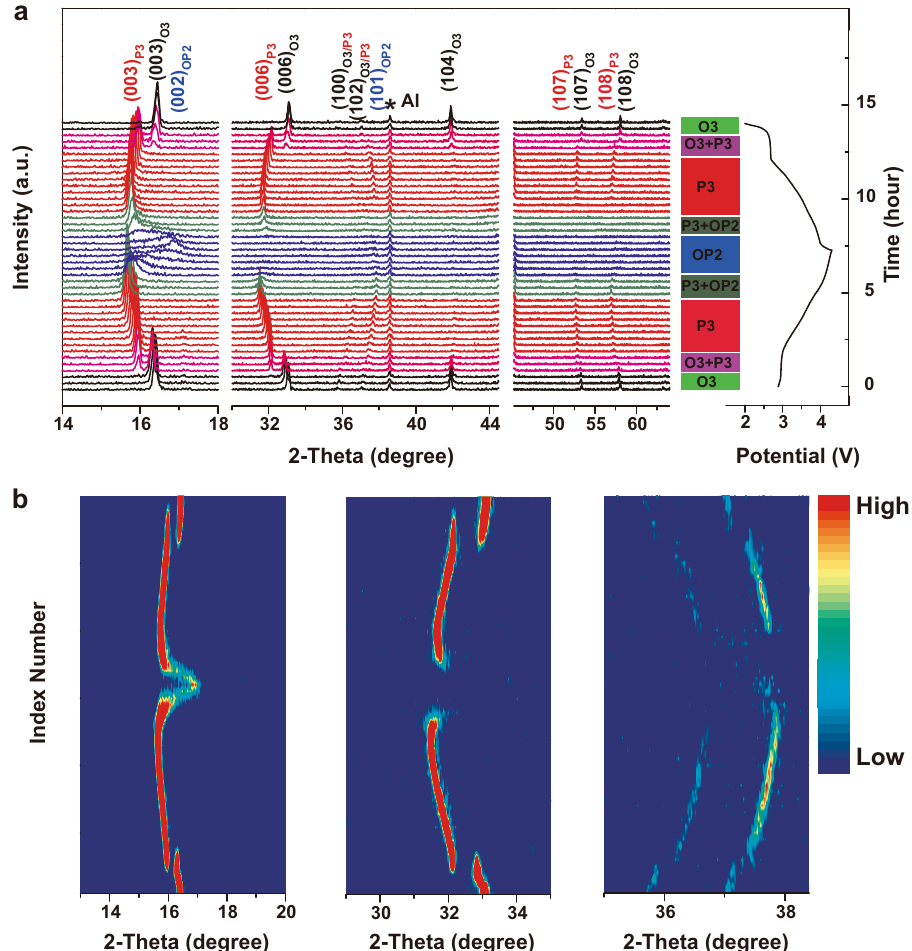
Fig. 6 Structural evolution of NLNFMB cathode material in half-cell con fi guration. In situ XRD patterns during the fi rst charge/discharge of NLNFMB at a current rate of 0.1C (25 mA g − 1 ) between 2.0 and 4.3 V ( a ). Contour plot of main peak evolution ( b